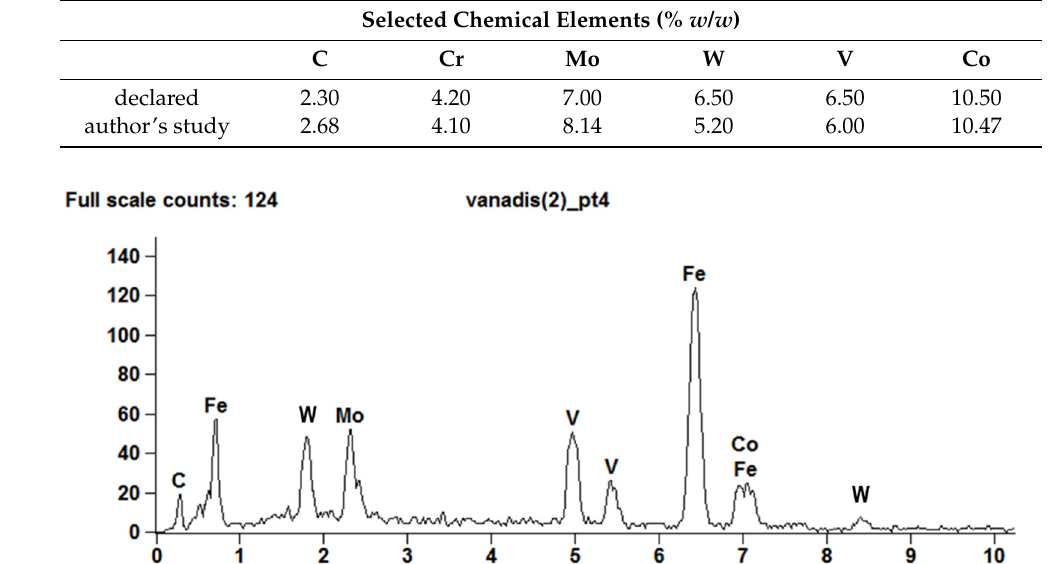
( b ) Figure 4. X ‐ ray dispersive energy spectrum of the areas M 6 C ( a ) and MC ( b ) visible in Figure 3. The increased content of W and Mo in the white areas, visible on the spectrum, indicates that these are carbides (W, Mo) 6 C, while the high content of V in the gray areas shows that they are carbides (V 4 C 3 ). The microstructure of Vanadis 60 Super Clean steel hardened in oil differed from that hardened in water in the number of carbide precipitates. The number of carbide precipitates was determined by the image analysis method using the Matlab Simulink 2020a program (MathWorks, Natick, MA, USA). For Vanadis 60 Super Clean steel hardened in oil, the proportion of all carbide phases on the surface was 25%, and for that hardened in water, it was 20%. The spectrographic tests of the chemical composition of Hardox 600 (Table 7, Figure 5) steel showed a chemical composition similar to that declared by the manufacturer. Due to the low concentration of boron, it is not detectable by energy dispersion spectroscopy (EDS).